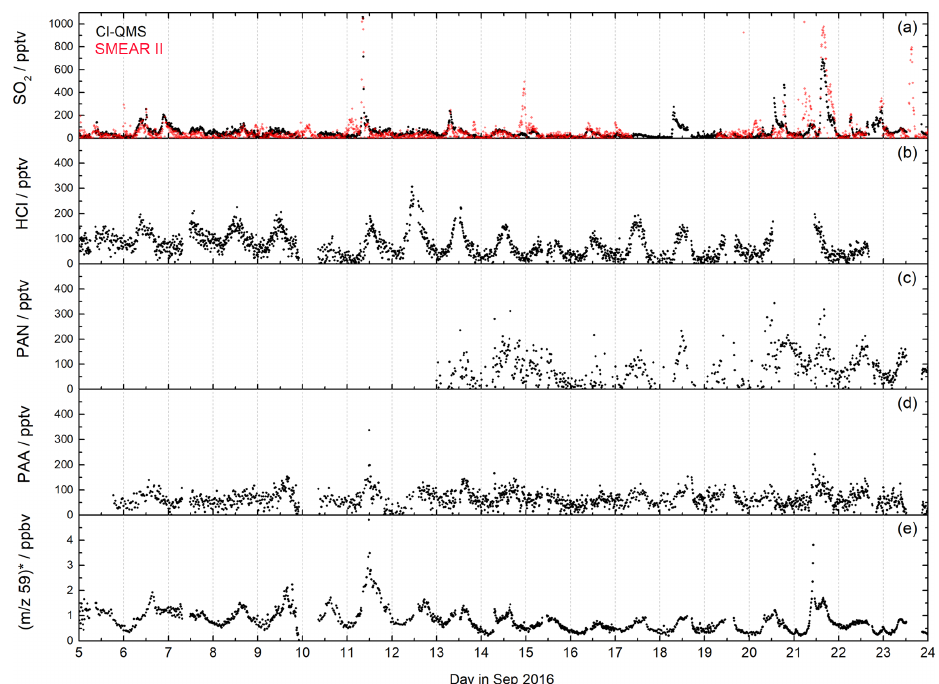
Figure 8. CI-QMS time series of SO 2 , HCl, PAN, PAA mixing ratios and m/z 59 during the IBAIRN campaign, which was undertaken in boreal forest. The red SO 2 trace was obtained using a TEI 43 CTL fluorescence analyser (SMEAR II). The signal at m/z 59 was converted toppbv assuming that it consists only of acetic acid (no peracetic acid). The mixing ratios are therefore only an upper